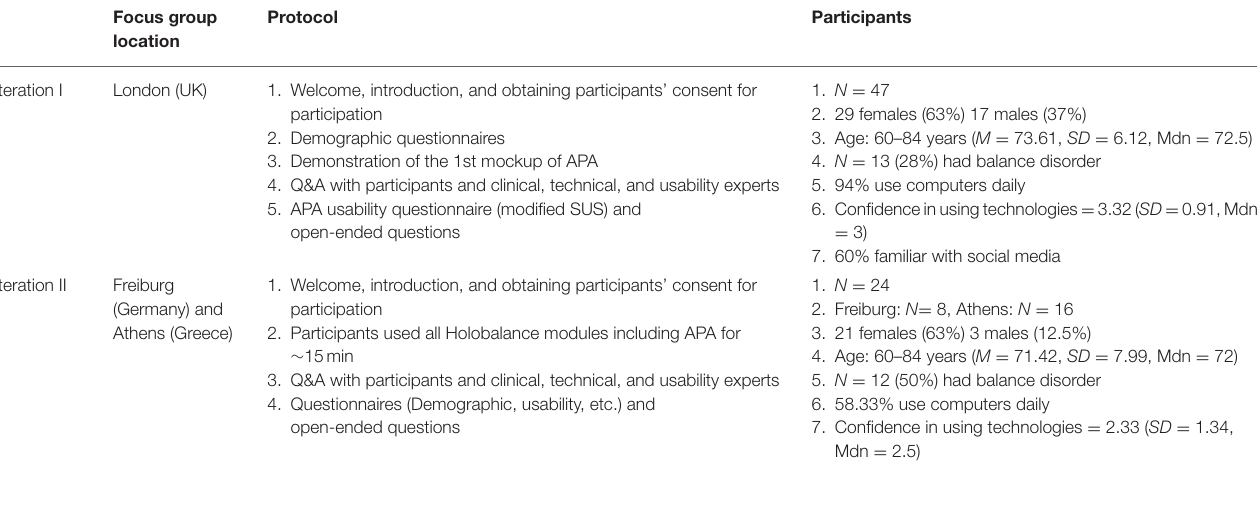
TABLE 2 | Information about the participants and the evaluation protocol of the semi-structured focus groups performed in UK, Germany, and